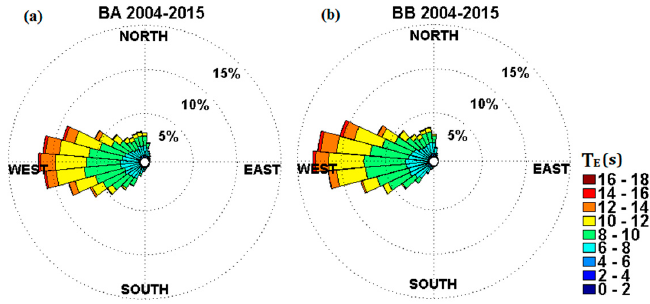
Figure 15. 12-year wave roses between T E and MWD at ( a ) BA and ( b ) BB.